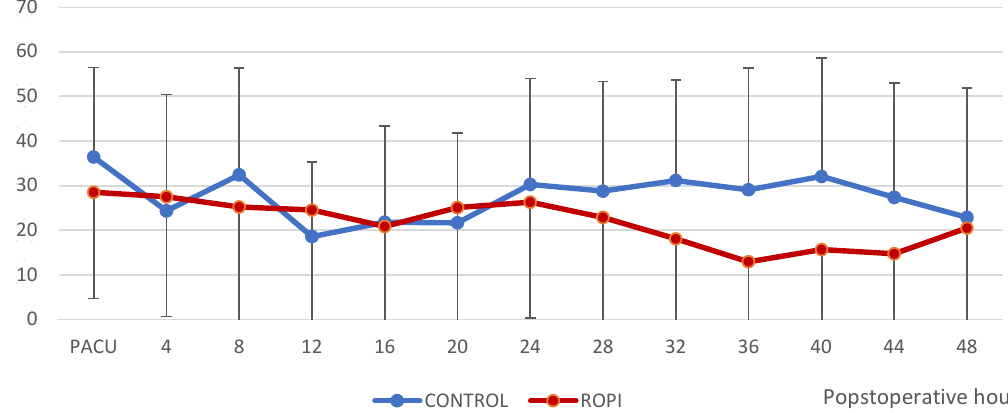
Figure 3. Pain scores at the cervical site at rest; mean and SD vs. postoperative time (hours) starting in PACU. Opioid consumption, which is a global consequence of pain at both sites, did not differ significantly between groups (Figure 4).